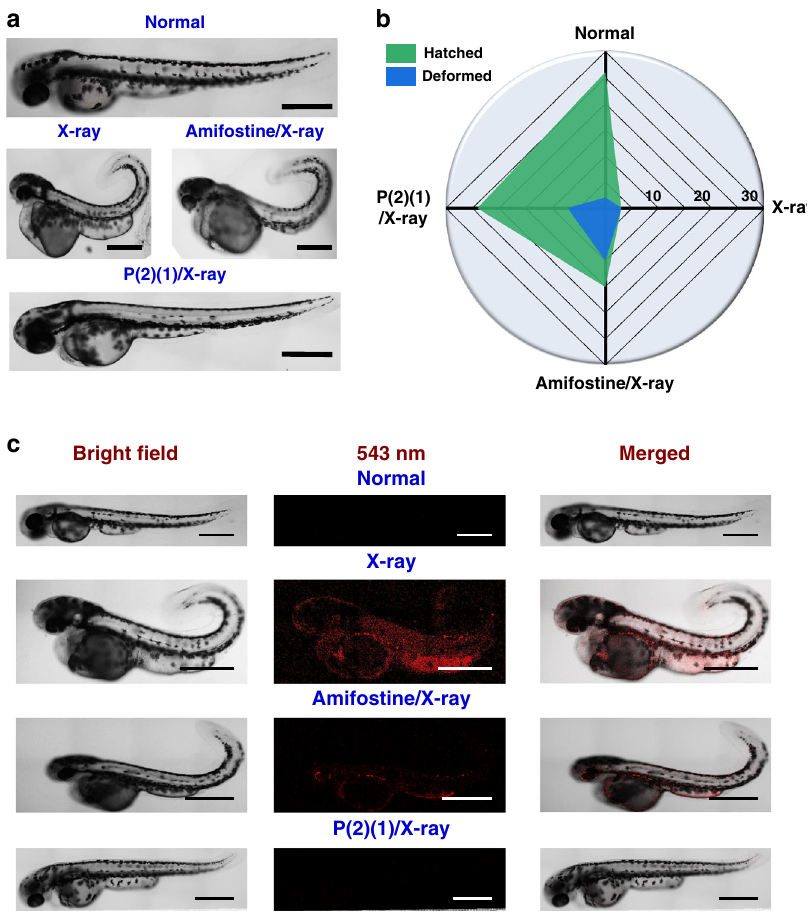
Fig. 7 Radiation sequela of zebra fi sh embryos in the presence of different compounds. a Representative pictures of zebra fi sh larvae hatched from embryos under different conditions. Seven days, scale bar = 500 μ m. b Hatched larvae number and deformed larvae number, 30 samples/group. c Damaged DNA in zebra fi sh larvae hatched from embryos under different conditions. Scale bar = 500 μ m. This experiment was repeated twice independently with similar results. Source data are provided as a Source Data fi